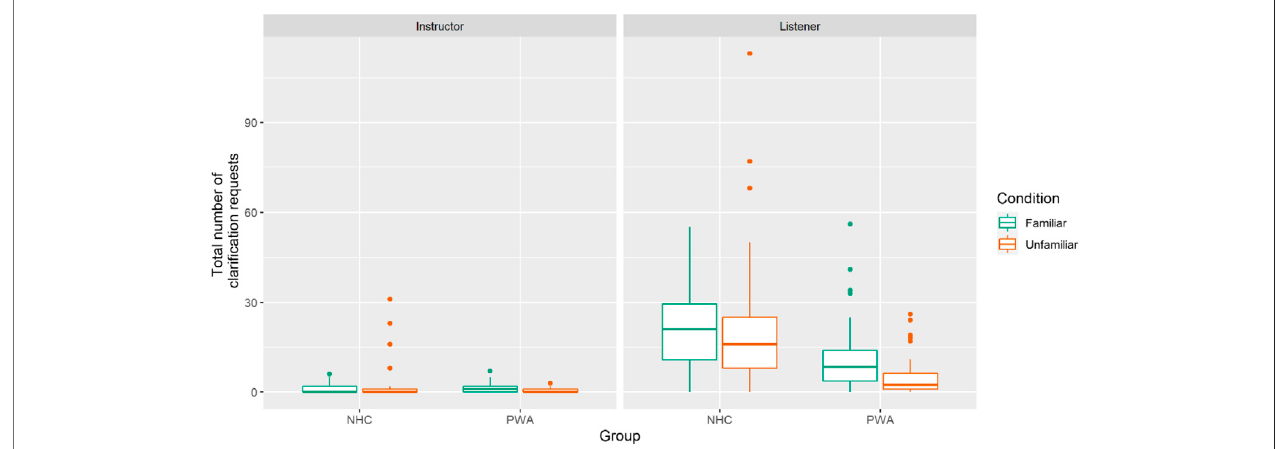
FIGURE 9 | Boxplots showing total number of clari fi cation requests by condition and group, for each role